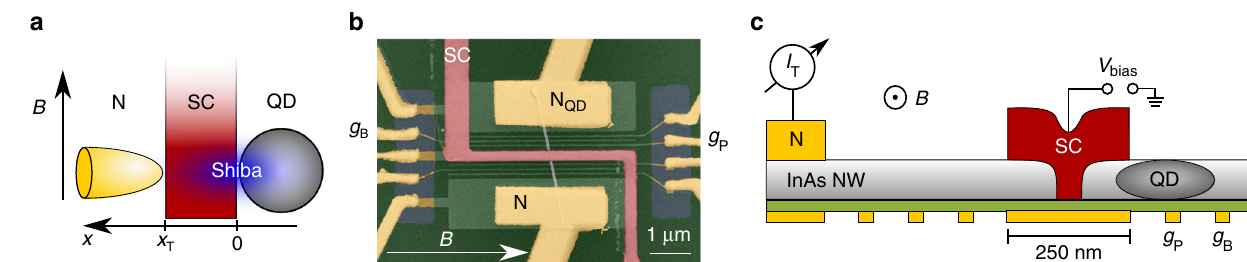
Fig. 1 Schematics of the setup. a The normal metal-superconductor-quantum dot (N – SC – QD) setup used in our measurements. The QD is strongly coupled to the s-wave superconductor, giving rise to the Shiba state. The normal lead N is coupled to the superconductor at a fi nite distance x from the T dot, and acts as a tunnel probe and measures the current as the energy of the Shiba state is tuned. The external magnetic fi eld B is applied in-plane of the wafer. b False color SEM image of the device, and c cross section of the device. The QD is formed in an InAs nanowire (gray) by applying voltages on the bottom gate electrodes (yellow). The plunger gate g controls the level position of the dot, the barrier gate g isolates the QD. Tunneling to N is controlled P B by a series of gates. The width of the superconductor is 250 nm and below the superconductor a segment with length of 50 – 60 nm is cut from the nanowire.